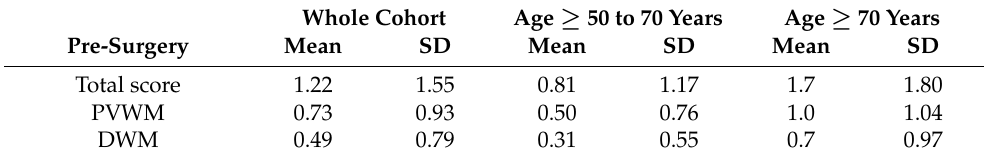
Table 6. Distribution of Fazekas scores (total score; PVWM; DWM) in patients’